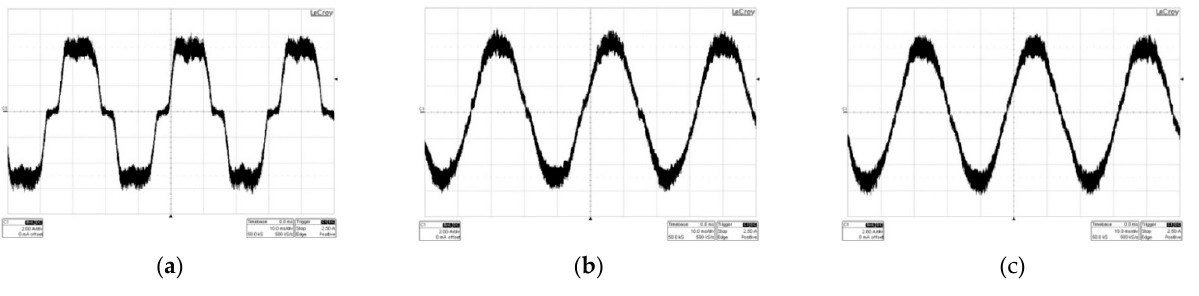
Figure 8. Test results: measured phase current: ( a ) without compensation; ( b ) with compensation using LPF; ( c ) with compensation using extended PLPF.